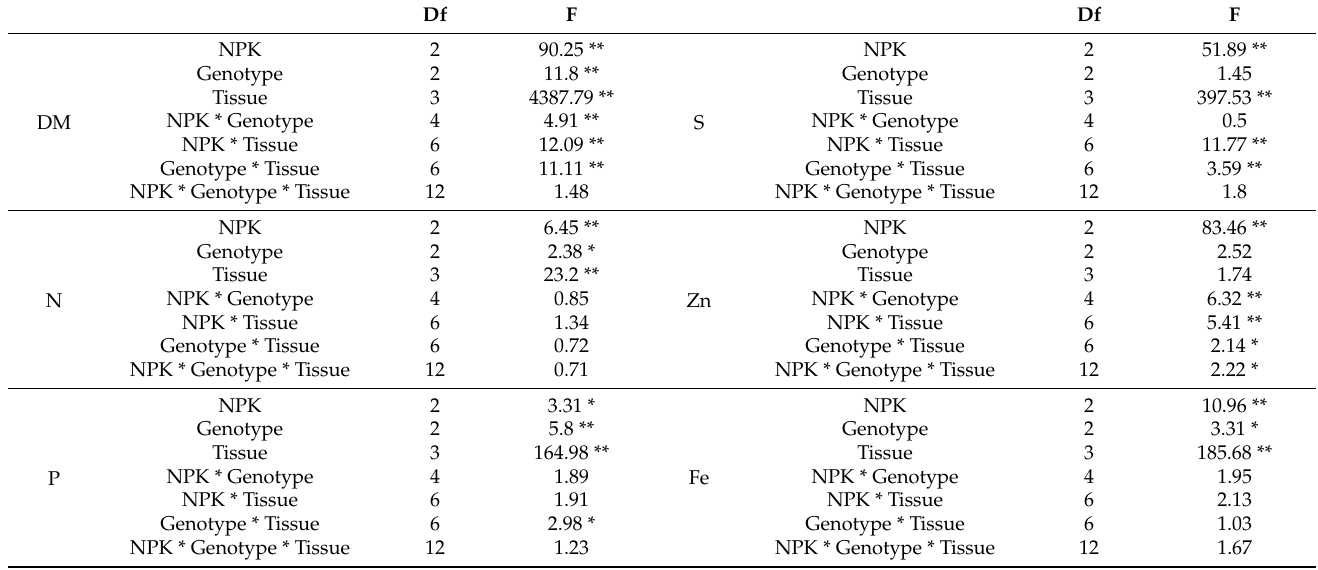
Table 1. Variance analysis of plant parts (tissues) of different maize hybrids for NPK fertilizer levels. Df